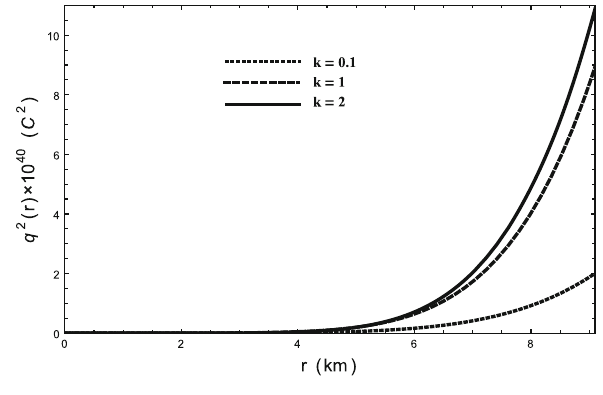
Fig. 4 Radial variation of charge q 2 ( r )